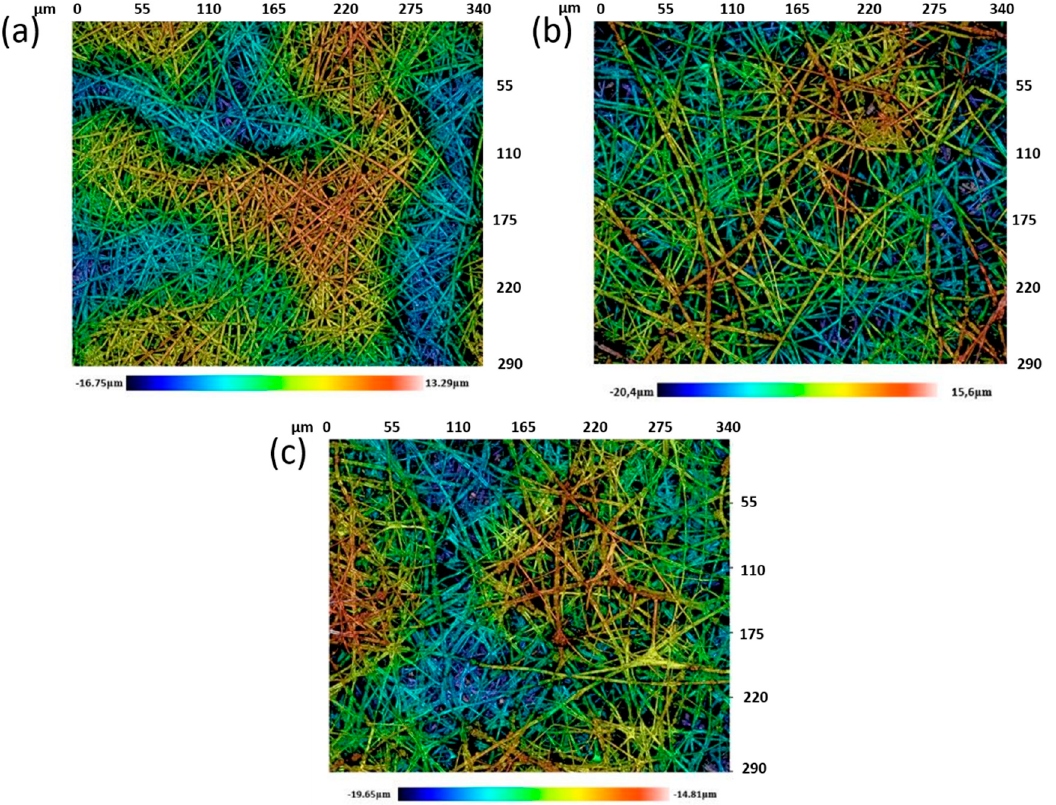
Figure 7. Confocal images of the samples of study for crosslinked electrospun PAA + β -CD fibers ( a ), PAA + β -CD + TiO 2 fibers ( b ) and PAA + β -CD + TiO 2 + Fe 2 O 3 fibers ( c ).